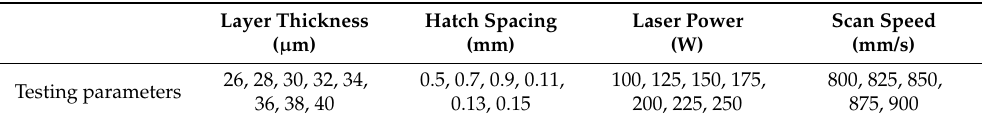
Figure 1. Figure 1. Illustrations of: ( a ) a commercial HBD ‐ 100D SLM machine, ( b ) SLM process, ( c ) as ‐ printed ( c ) as-printed samples, and ( d ) three-dimensional coordinated system of the investigated nickel- samples, and ( d ) three ‐ dimensional coordinated system of the investigated nickel ‐ based superalloy based superalloy specimen. specimen. Table 2. Lists of testing parameters used to obtain the optimized processing parameters during SLM